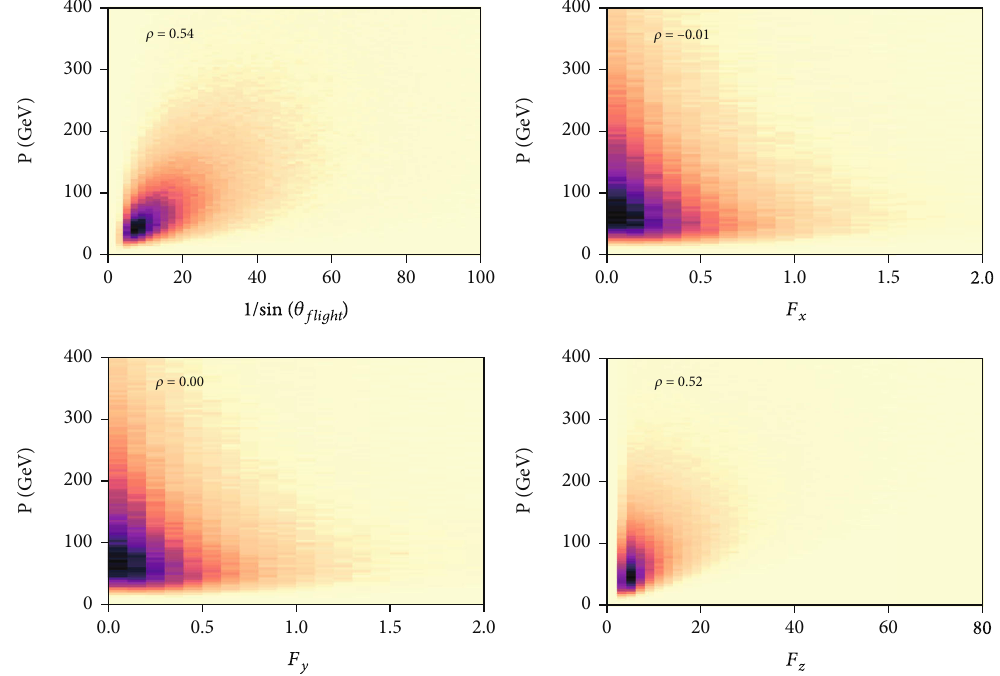
Þ , F F F x , y , and z versus the flight